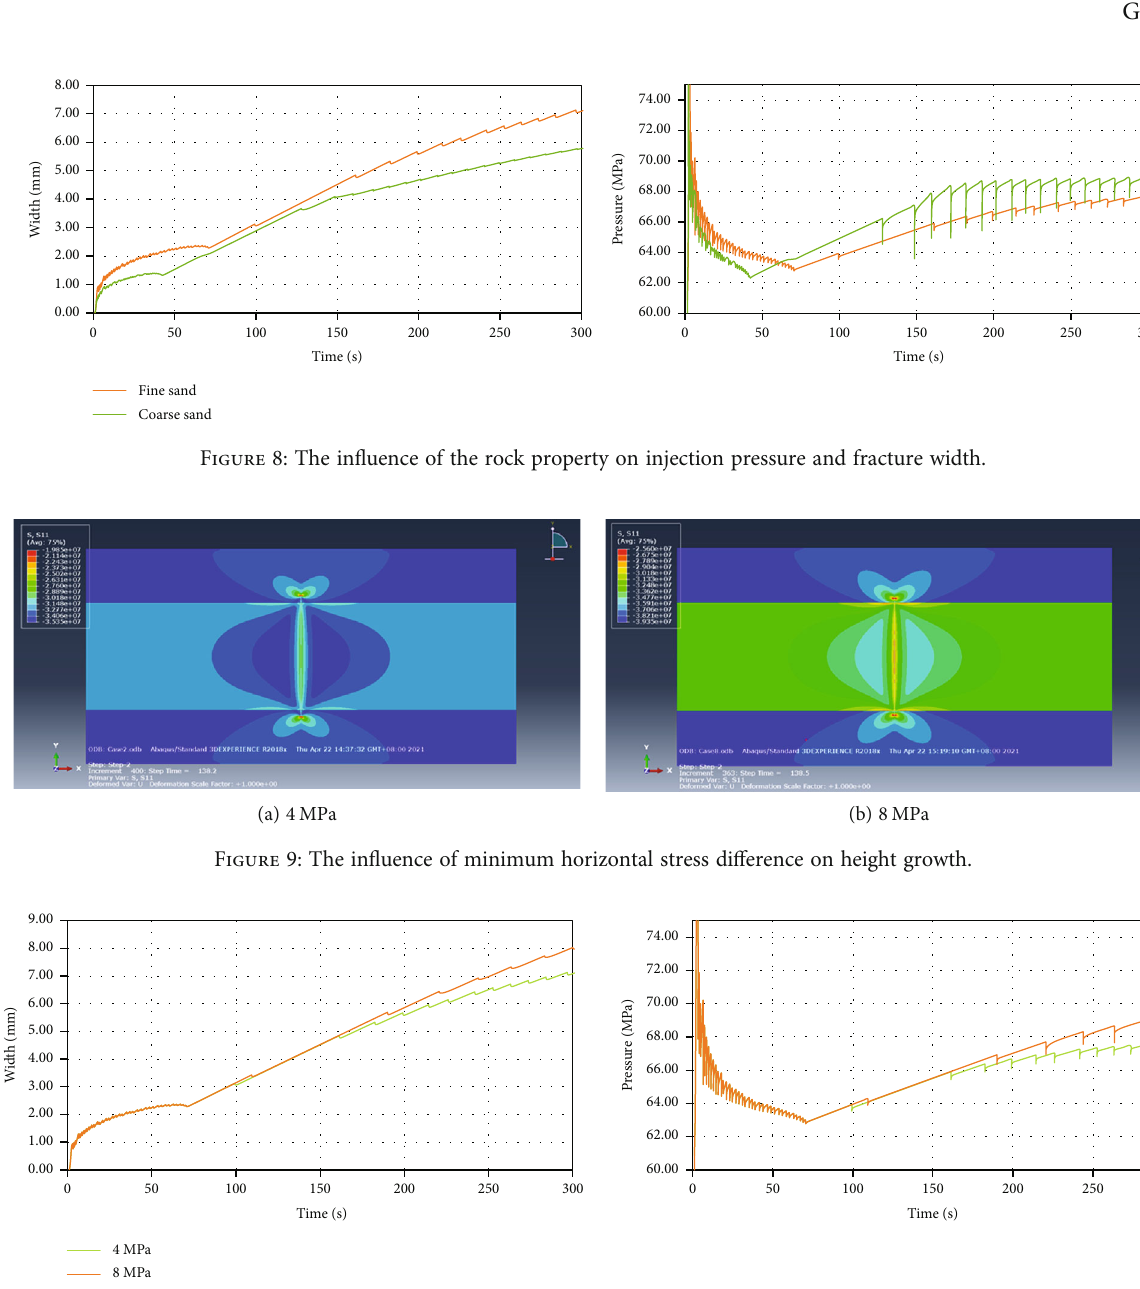
Figure 10: The in fl uence of minimum horizontal stress di ff erence on injection pressure and fracture